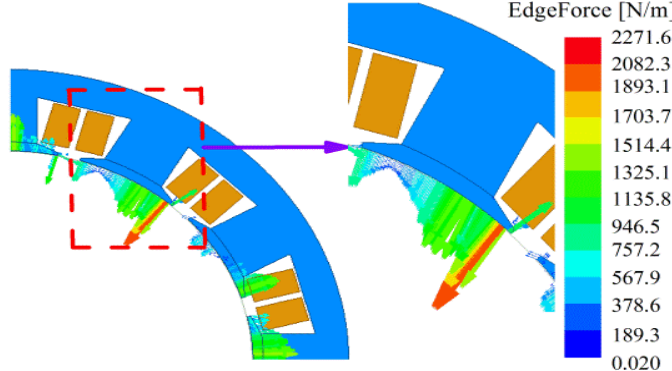
Figure 2. Radial force density distribution of stator teeth.